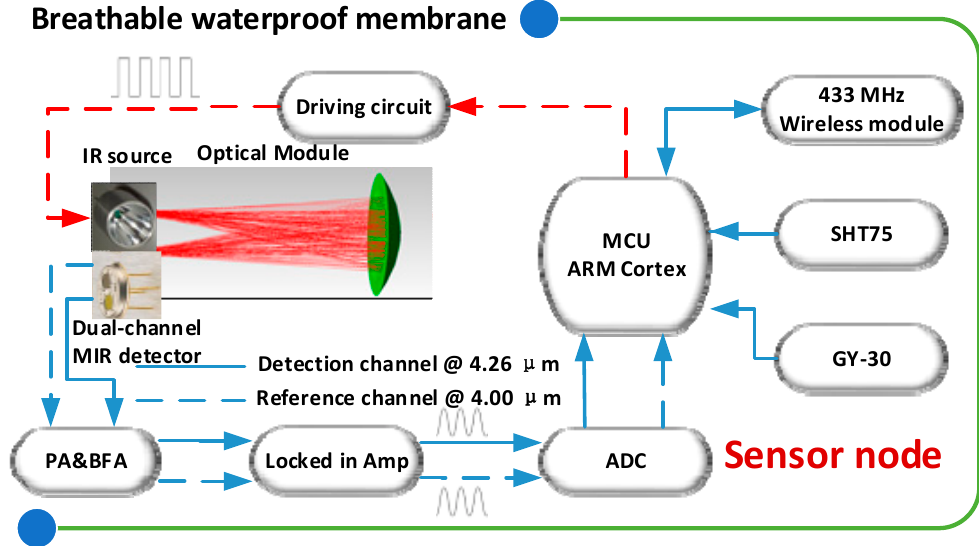
Figure 2. Structure of a CO 2 sensor node using NDIR (non-dispersive infrared) technology. For measurement of environmental factors, a temperature and relative humidity multi sensor (type: SHT15, Sensirion, Laubisruetistrasse, Switzerland) was selected due to advantages including calibrated digital output, high reliability, and excellent long-term stability based on industrial CMOS